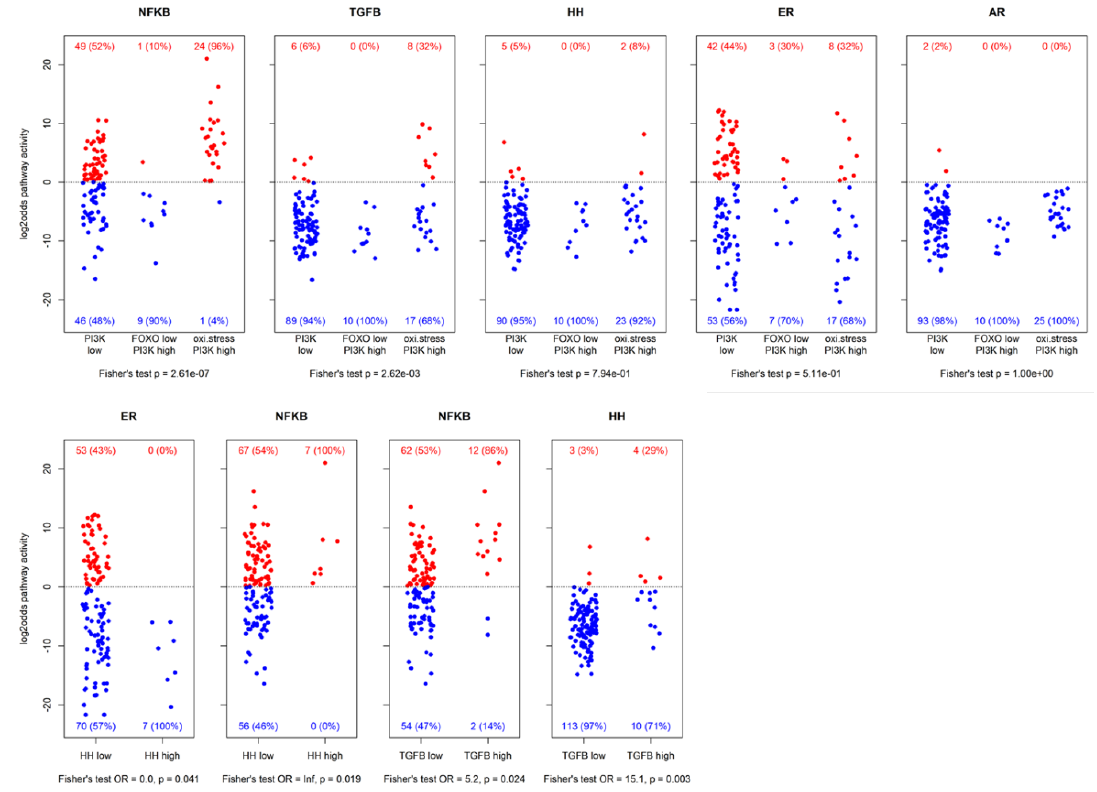
Figure 3. Resulting log2odds scores of pathway analysis across different groups of samples. The top row shows activity for PI3K pathway inactive, FOXO-low PI3K pathway active, and oxidative stress PI3K pathway active samples. The bottom row shows activity of some pathways vs. HH pathway activity and TGFβ pathway activity. Patient numbers are indicated with corresponding percentages (between brackets). Reported p-values are nominal.